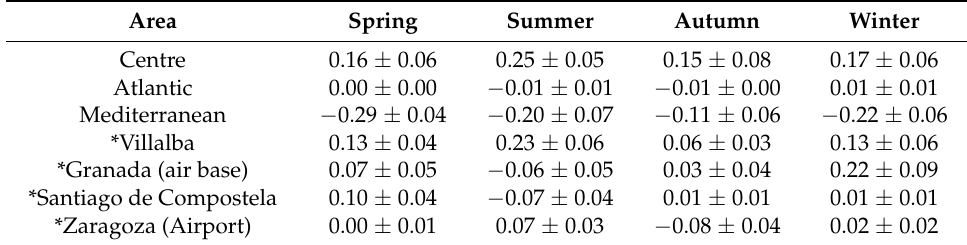
Table 3. Seasonal DTR trends ( ◦ C decade − 1 ) at three different areas and four rural stations (*) with the corresponding mean standard error in Spain for the period 1950–2011 The results are significant at the 0.05